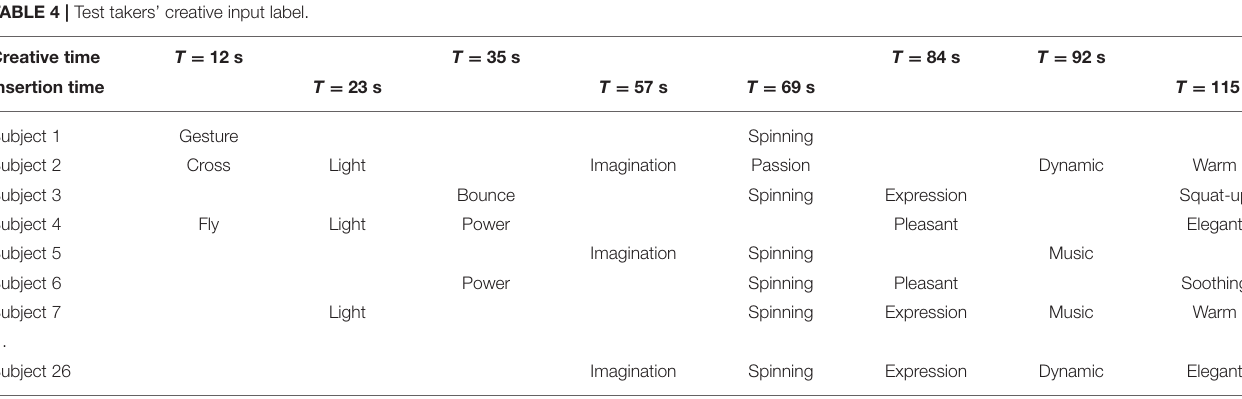
TABLE 4 | Test takers’ creative input